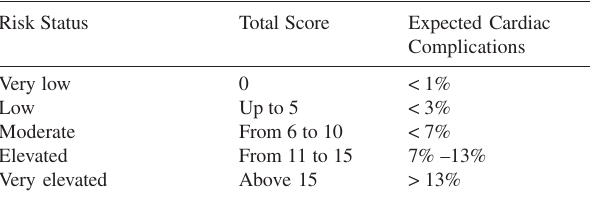
Table 1 - Complication risk index according to the EMAPO